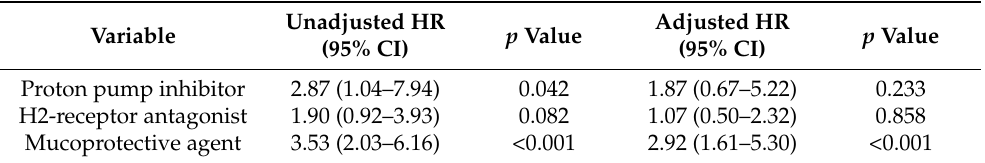
Table 3. Risk for gastrointestinal bleeding according to the use of anti-ulcerative medications after myocardial